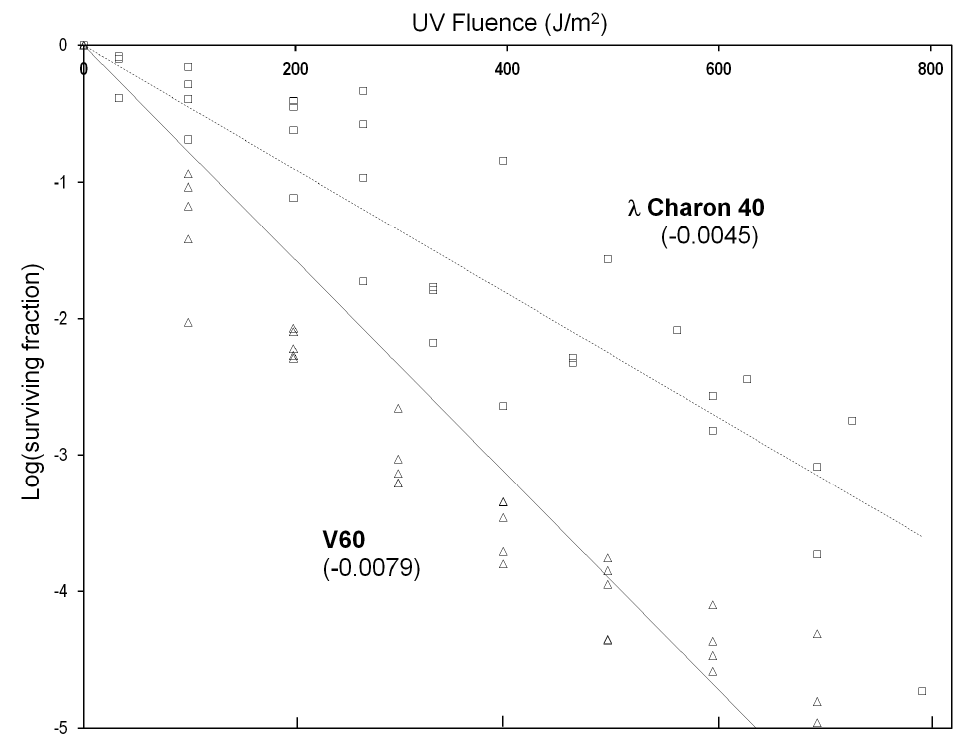
Figure 4. Virion inactivation by UV-C radiation. Virion suspensions in UV-transparent buffer (SM for λ [30], S dil for V60) were irradiated with agitation at room temperature in the dark with a germicidal lamp. The indicated doses represent the UV-C component of the lamp output (wavelengths < 300 nm). Aliquots were withdrawn as indicated and assayed by plaque counting (see Section 2). Numbers in parentheses are first-order rate constants calculated as the slopes of linear regressions of all plotted points, as shown in the graph. Limiting the V60 data to the first four UV doses yields a slope of − 0.0097 m 2 /J.